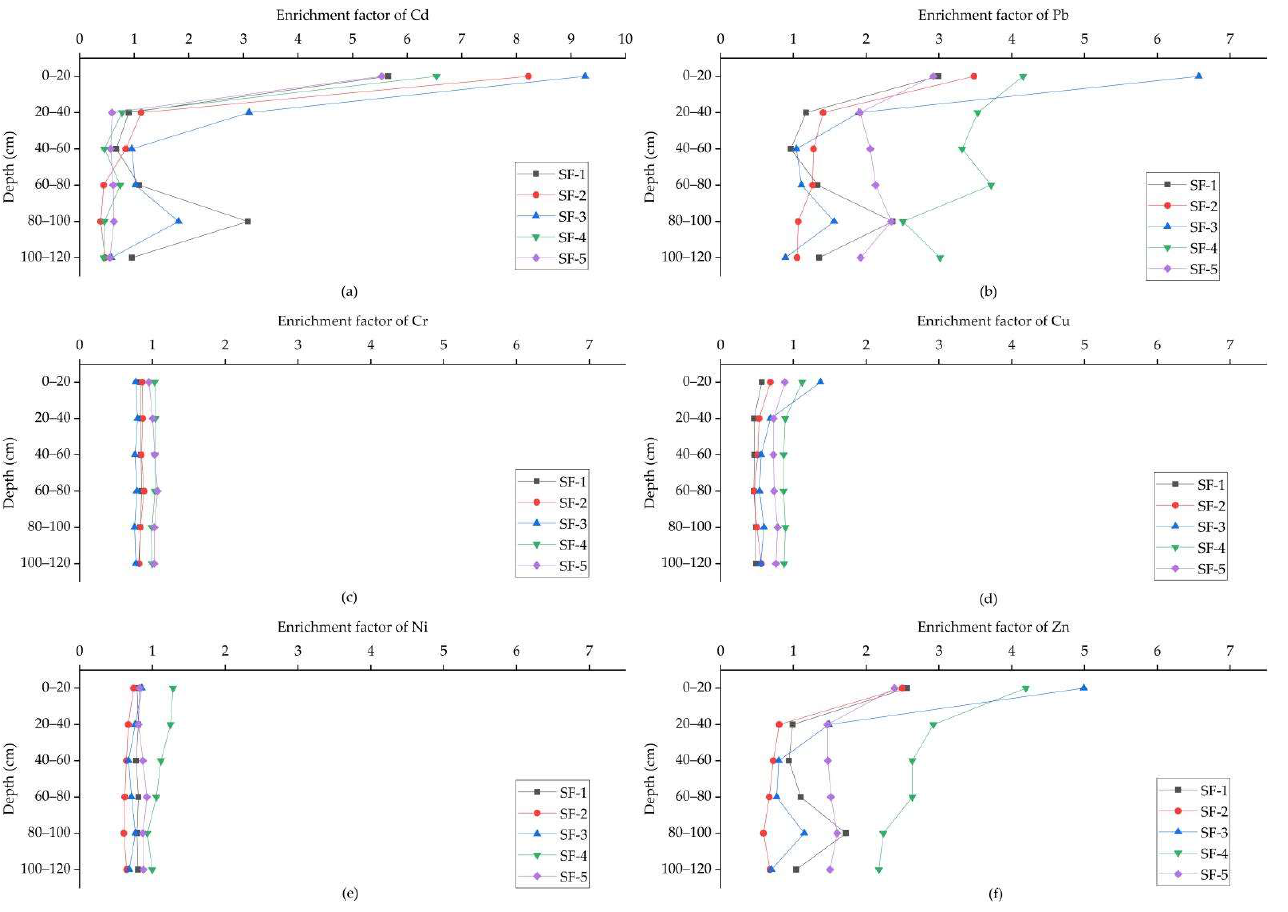
Figure 6. Enrichment factor (EF) of Cd ( a ), Pb ( b ), Cr ( c ), Cu ( d ), Ni ( e ) and Zn ( f ) in soil profiles.